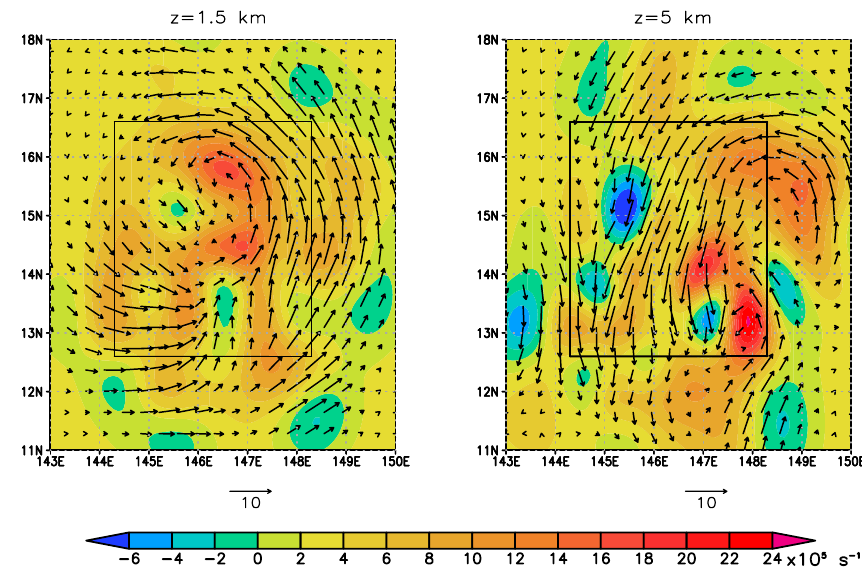
Figure 7. Two-panel plot of absolute vorticity (shaded) and wind vectors (co-moving) for Nuri 1 at 1.5km (left) and 5km (right) height from the 10km SAMURAI analyses. The black box is the four-degree length box centered on the 25km analysis 1.5km altitude sweet spot position and is for reference only. The abscissa is longitude and the ordinate is latitude.